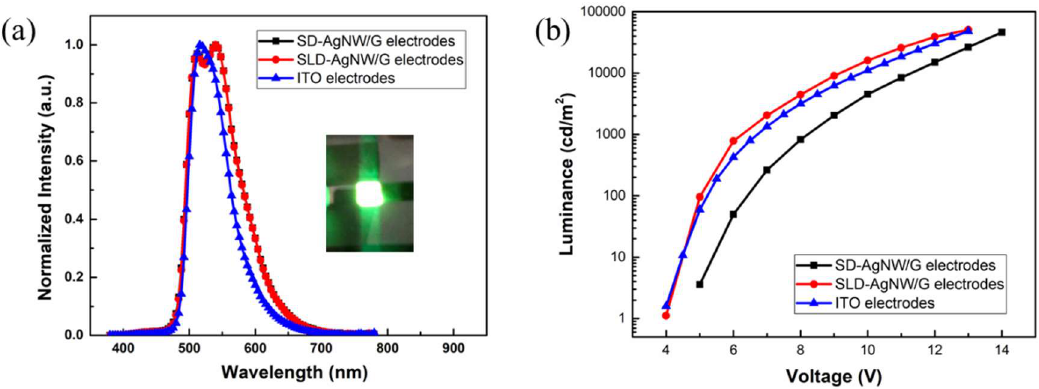
Figure 8. ( a ) The spectrum and ( b ) luminance–voltage characteristics of OLED devices with ITO, SD‐AgNW/G and SLD‐AgNW/G film as anodes.